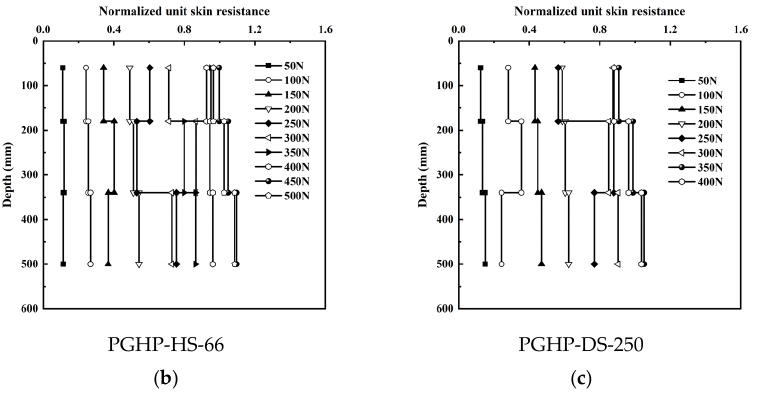
Figure 15. Normalized unit skin resistance: ( a ) helix number test sets, ( b ) helix size test sets, and ( c ) drilling speed test sets.